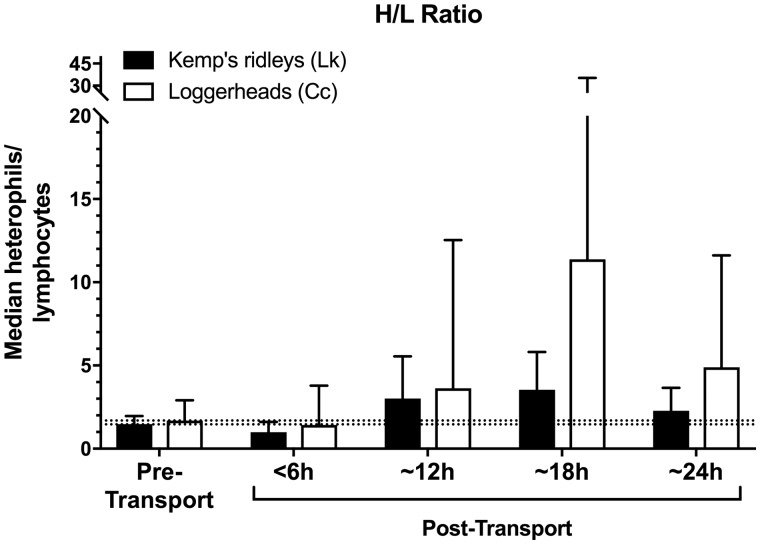
Post-transport heterophil/lymphocyte (H/L) ratio in Kemp’s ridley and loggerhead turtles when compared with pre-transport baselines. Dashed lines indicate pre-transport medians (i.e., bars on left), for visual comparison to post-transport concentrations in both species. H/L ratio was not normally distributed; bars indicate median±quartiles.